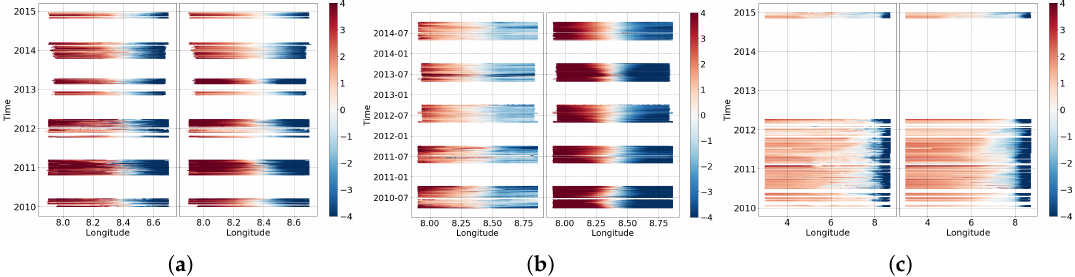
Figure 10. Salinity anomalies from the three ferry lines and corresponding model results. The observational data are on the left and the corresponding model results are on the right of each panel. Ferries: ( a ) Cuxhaven–Helgoland; ( b ) Büsum–Helgoland; and ( c ) Cuxhaven–Immingham.